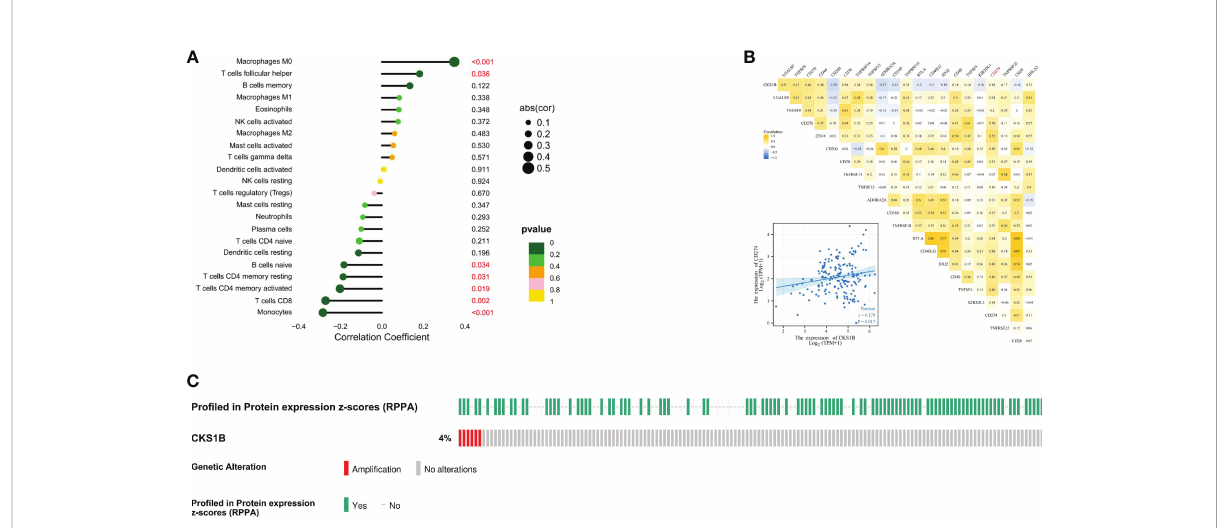
FIGURE 5 The expression of CKS1B correlates with immune checkpoint in pancreatic cancer. (A) The correlation of CKS1B expression with immune cells. (B) The relationship between CKS1B expression and immune checkpoints. (C) The genetic alteration of